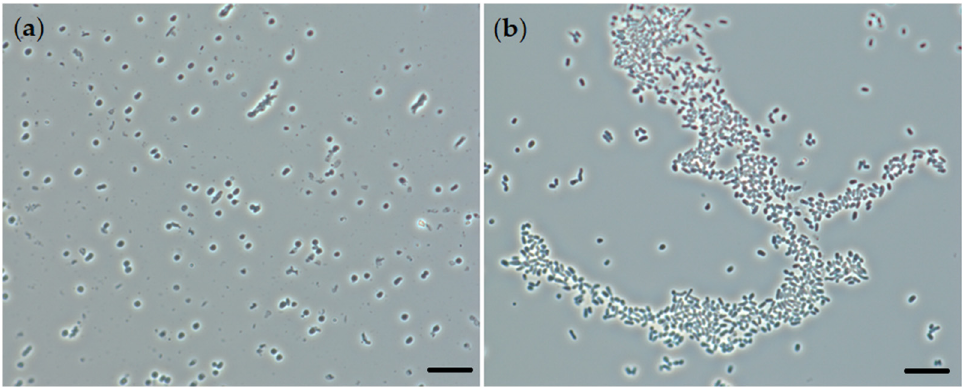
Figure 3. The rate of oxygen consumption ( a ) and amount of oxygen consumed ( b ) by R. rhodochrous